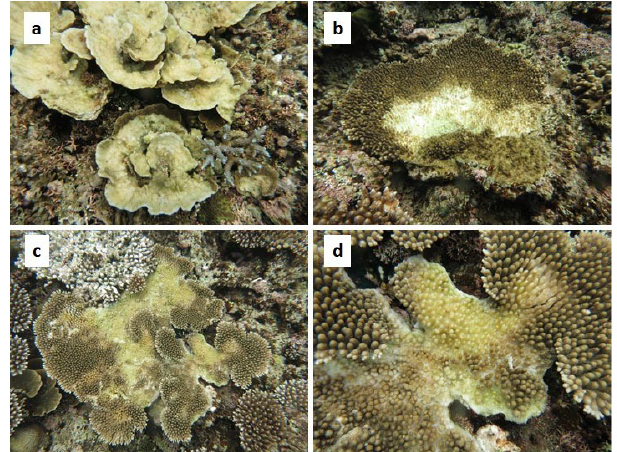
Figure 1. ( a ) Dead and dying Montipora aequituberculata colonies ( b ) Acropora hyacinthus colony with bleached and dying tissue in the middle of the colony ( c ) a second A. hyacinthus colony ( d ) close up of the colony in ( c ). Images were captured using a Canon S100 digital camera in waterproof housing.